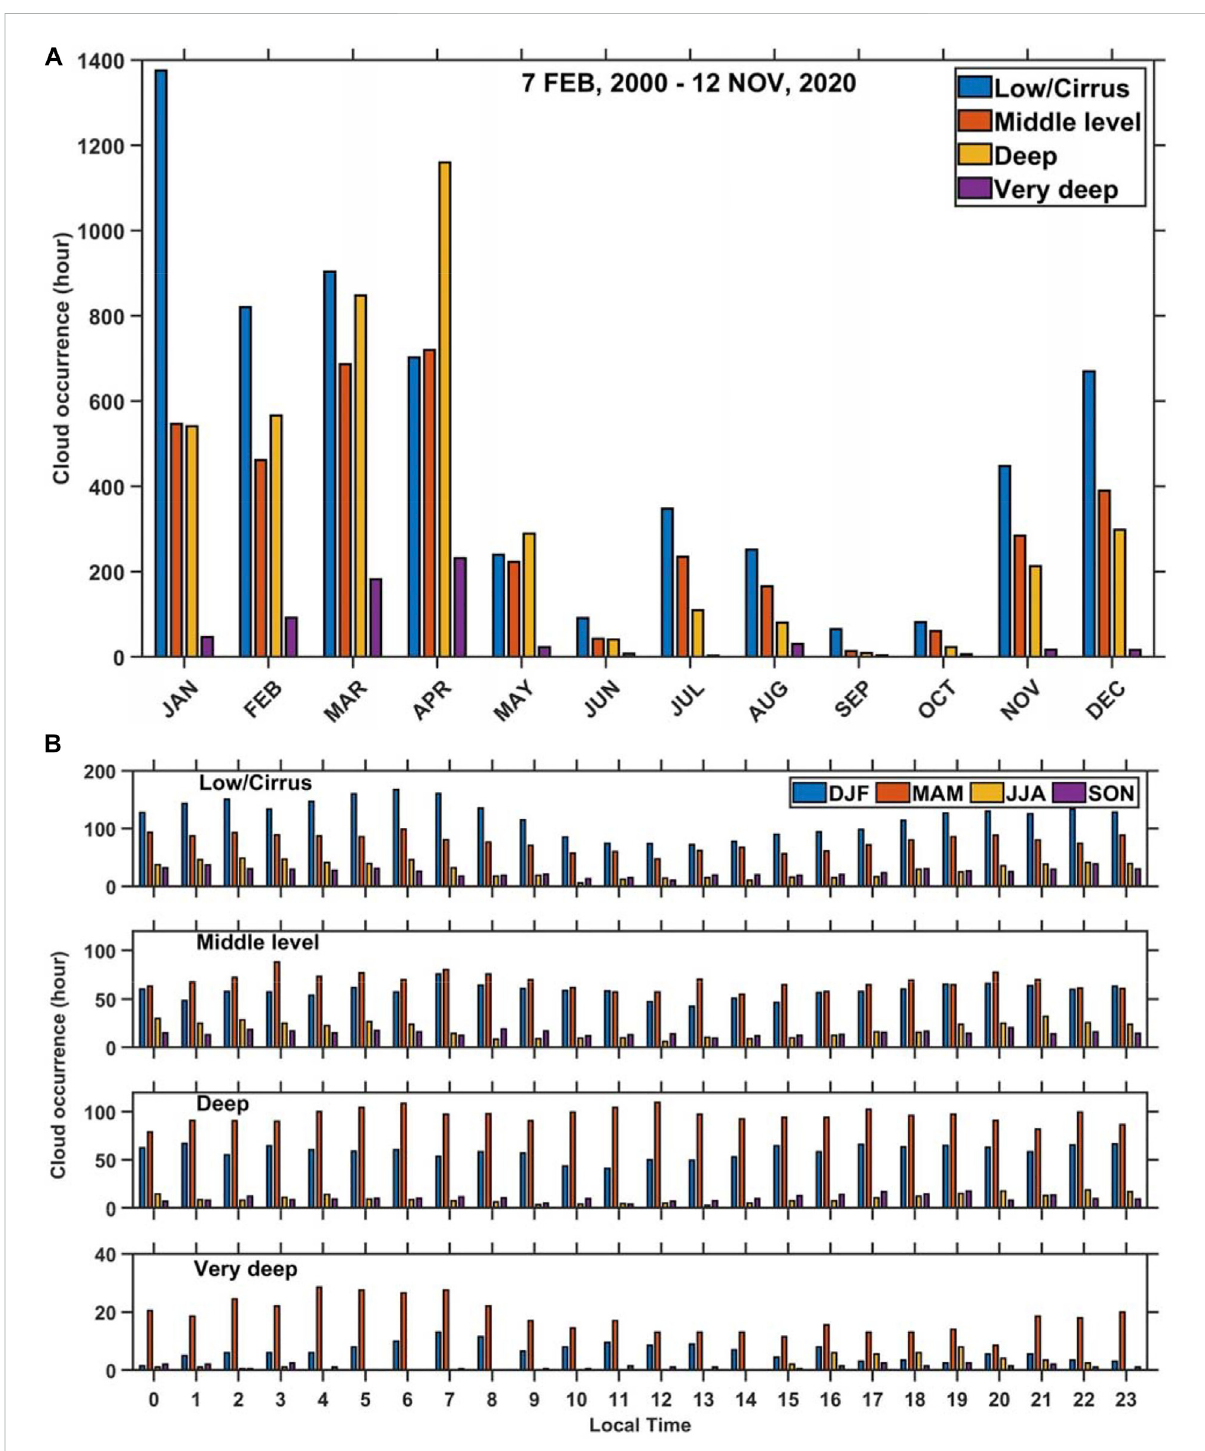
FIGURE 9 (A) Monthly occurrence (hours) of low-level/cirrus, mid-level, deep and very deep convective clouds following Reddy and Rao (2018) for the period 07 February 2000 – 12 November 2020 at Barakah. (B) gives the diurnal frequency of each cloud type for each